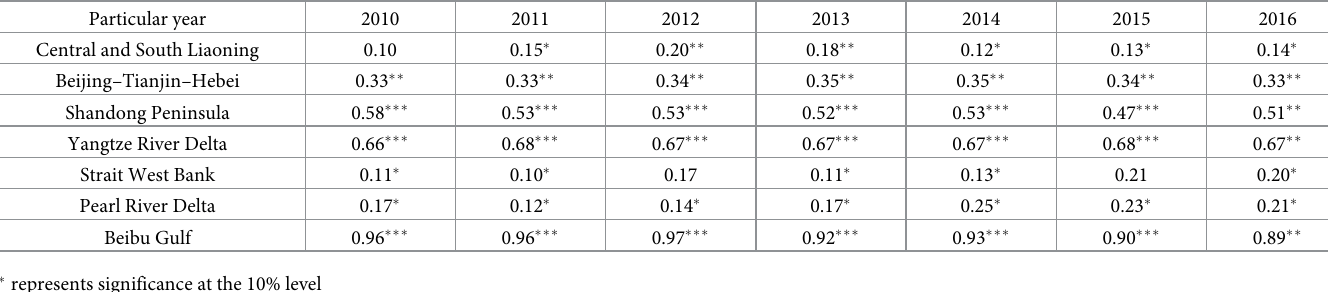
Table 3. Spatial autocorrelation indices for annual average PM 2.5 concentration in China’s coastal urban agglomerations from 2010 to 2016. Particular